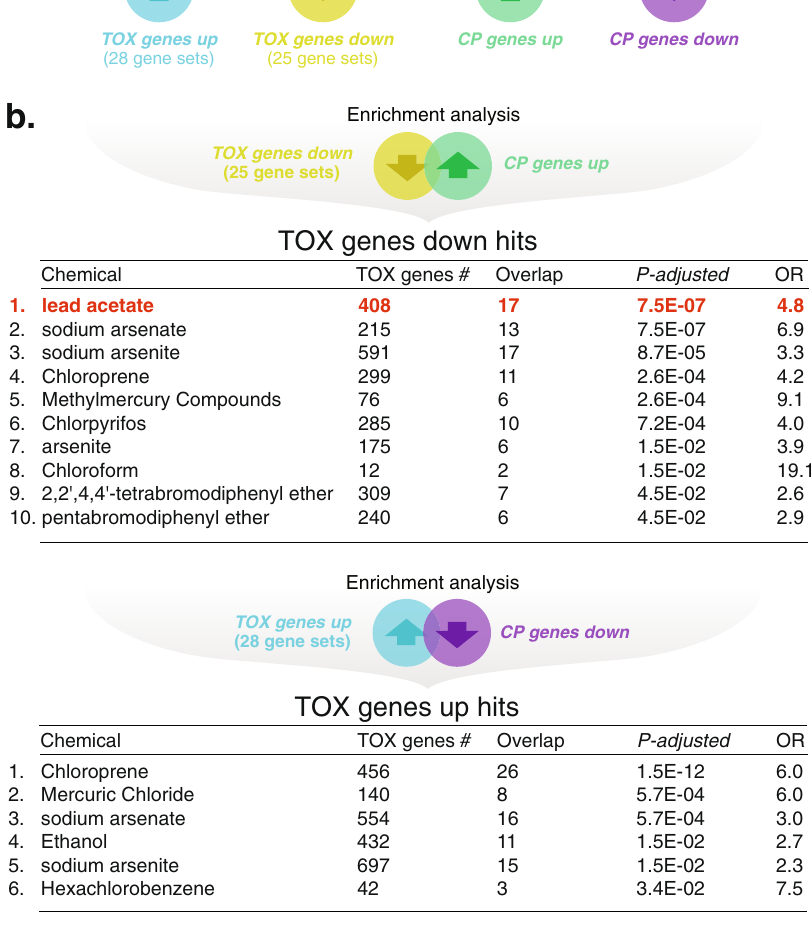
Figure 2. Informatics reveals lead (Pb) as a top neurotoxicant to dysregulate critical period gene expression. ( a ) To facilitate hypothesis testing that the 28 neurotoxicants identified in Fig. 1 disrupt rather than enhance critical period-related gene expression and plasticity, we split the 28 TOX composite gene sets into transcripts increased or decreased by a given neurotoxicant ( TOX genes up and TOX genes down ) and split the critical period signature into genes increased or decreased in the critical period ( CP genes up and CP genes down ). Note: the TOX genes down library contains 25 gene sets due to 3 of the gene sets not reaching the minimum size threshold once split. ( b ) Using a directional enrichment analysis by quantifying the overlap of TOX genes down with CP genes up or TOX genes up with CP genes down yielded 10 and 6 neurotoxicants expected to reverse critical period gene expression (Hypergeometric tests, threshold P adj < 0.05). In both the non-directional (Fig. 1) and directional approaches, lead (Pb) ranked high in its expected ability to dysregulate critical period signature genes (Hypergeometric tests, non-directional: OR = 2.4, P adj = 1.5 × 10 − 05 ; directional: OR = 4.8, P adj = 7.5 × 10 − 07 ; see also Tables S1 and S2). In the case of ties, results were ordered alphabetically by neurotoxicant